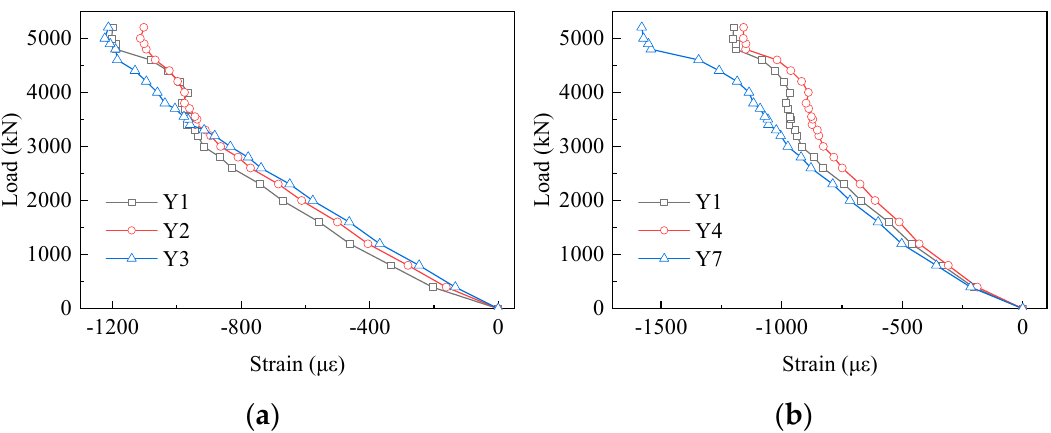
Figure 12. Load–strain curves of the compressive truss-web member: ( a ) Y1, Y2, Y3; and ( b ) Y1, Y4, Y7; Y1: No. 1 strain gauge of compressive truss web.